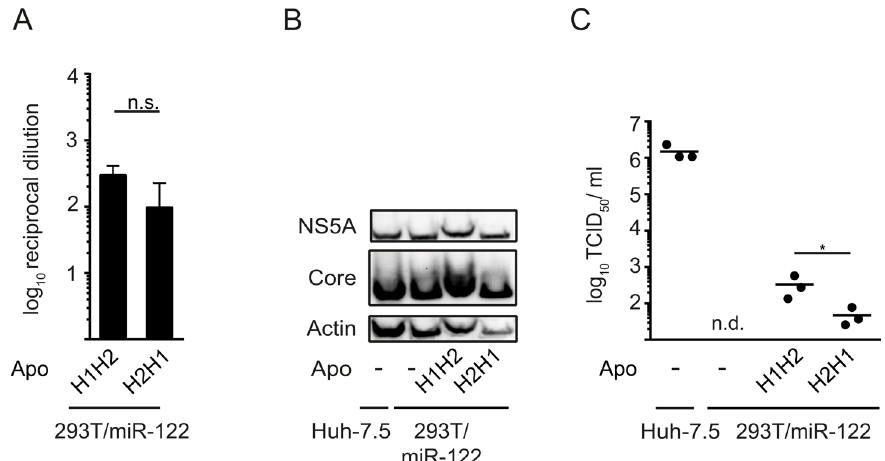
Fig 6. Switching the order of amphipathic alpha-helices in ApoC1 does not ablate its function in production of infectious HCV particles. A: Secretion of wild-type ApoC1 (H1H2) and a mutant containing swapped amphipathic alpha-helices (H2H1) was quantified via HA-specific ELISA. Depicted are average values of 3 independent experiments with reciprocal dilutions of secreted proteins that reach an OD of 2-fold over background (cells expressing the empty vector). Significant changes compared to wild-type ApoC1 were calculated based on one-tailed unpaired t test with Welch ’ s correction. n.s. = non-significant (p > 0.05). B: and C: Depicted cell lines were transfected with HCV RNA (Jc1 wt) by electroporation and the expression of core protein, NS5A and ß-actin were determined by Western blotting. C: Absolute values of viral infectivity were determined by end point dilution assay. Plotted are individual results of three independent experiments with means presented as a dash. Data were analyzed by one-tailed unpaired t test with Welch ’ s correction ( * = p < 0.05), n. d. = not